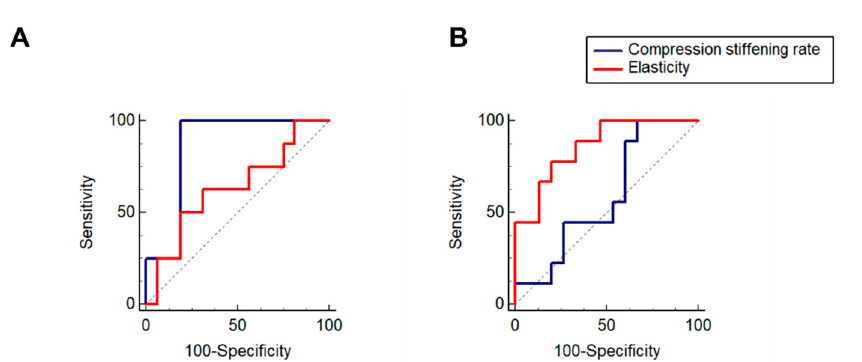
Figure 3. ( A ). Receiver operating characteristic curves of compression stiffening rate and elasticity for high solid stress ( A ) and substantial collagen content ( B ). Compression stiffening rate has high performance in diagnosing elevated solid stress (AUC: 0.86 ± 0.08), in contrast to elasticity (AUC: 0.63 ± 0.12) ( A ). Elasticity has high performance in diagnosing collagen content (AUC: 0.86 ± 0.08), in contrast to compression stiffening rate (AUC: 0.59 ± 0.12) ( B ).